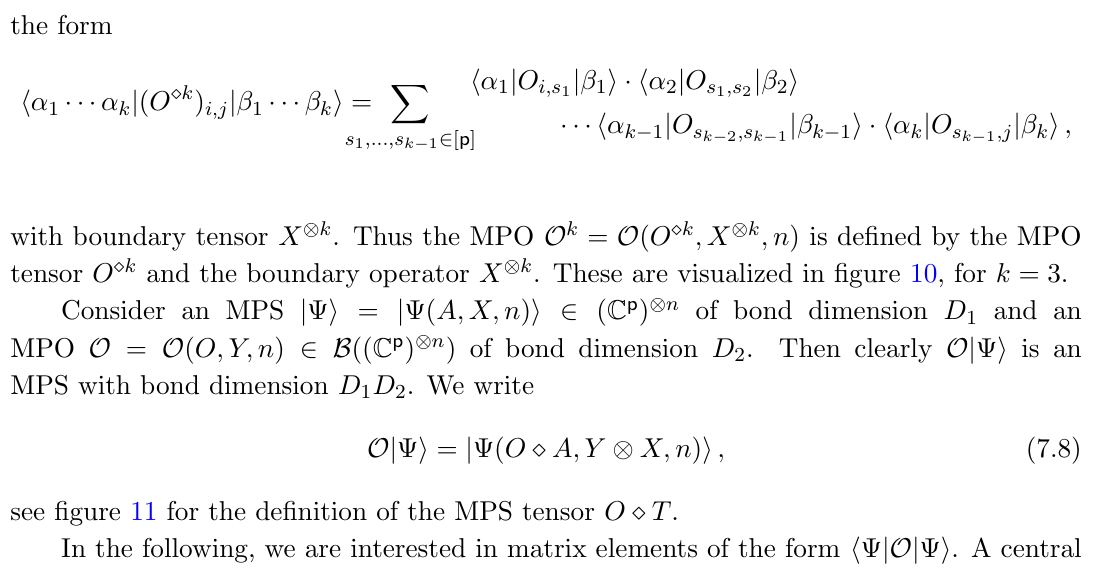
Figure 10 . This (cid:12)gure shows an MPO O = O ( O; X; 2) de(cid:12)ned in terms of matrices f O i;j g i;j and the matrices f O (cid:5) 3 g i;j de(cid:12)ning the MPO O 3 . Left-multiplication by an operator corresponds to i;j stacking a diagram on